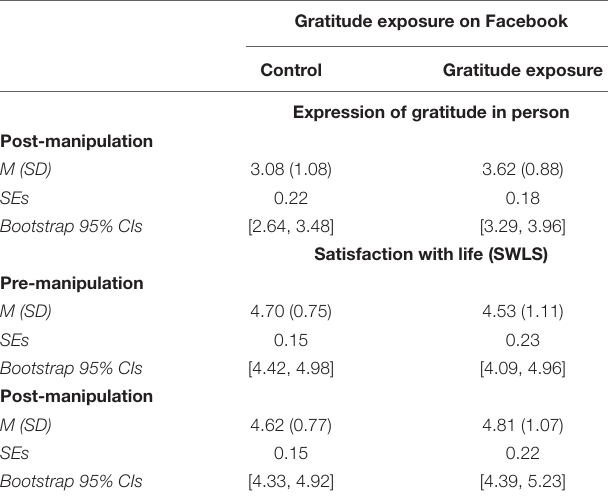
TABLE 1 | Average expression of gratitude in person and average scores obtained in the Satisfaction With Life Scale (SWLS) as a function of gratitude exposure on Facebook (control vs. gratitude exposure) and time (pre- vs.